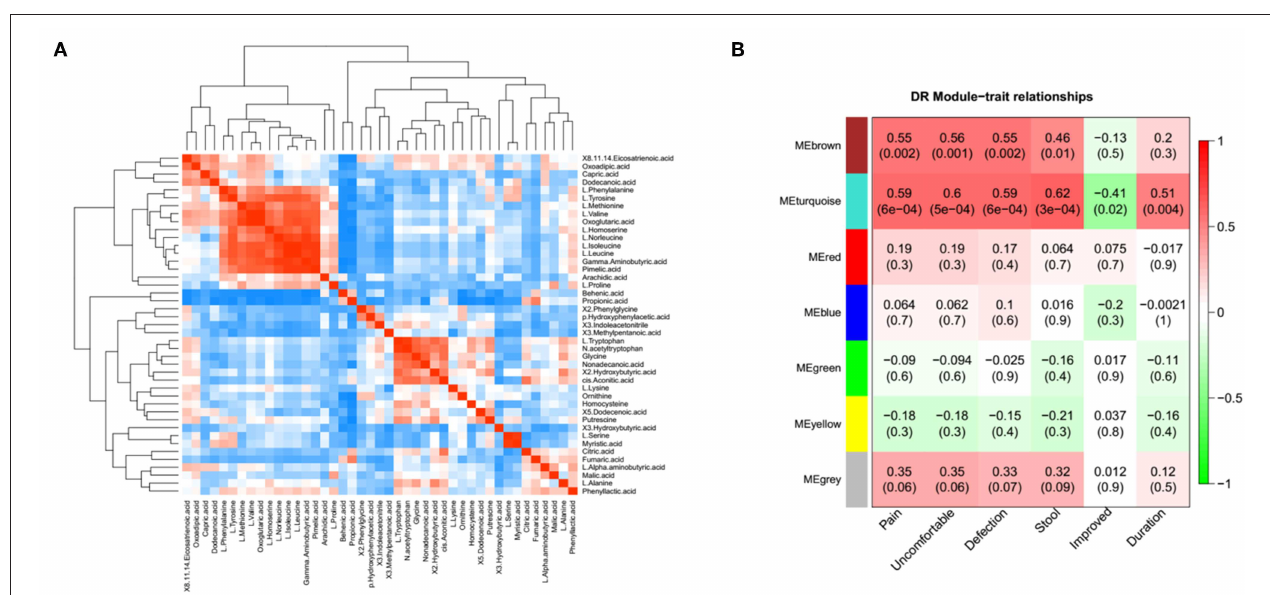
FIGURE 3 | The association between metabolomic profile and severity of IBS. (A) The correlation matrix indicated that some metabolites were positively correlated with each other and some metabolites were negatively correlated with each other. Among them, partial amino acid is positively correlated with organic acid, such as L-Isoleucine with adipic acid. (B) Module-trait association of metabolites. Each row corresponds to a module, column to a trait. Each cell contains the corresponding correlation and P -value. Each table is colored by correlation according to the color legend on the